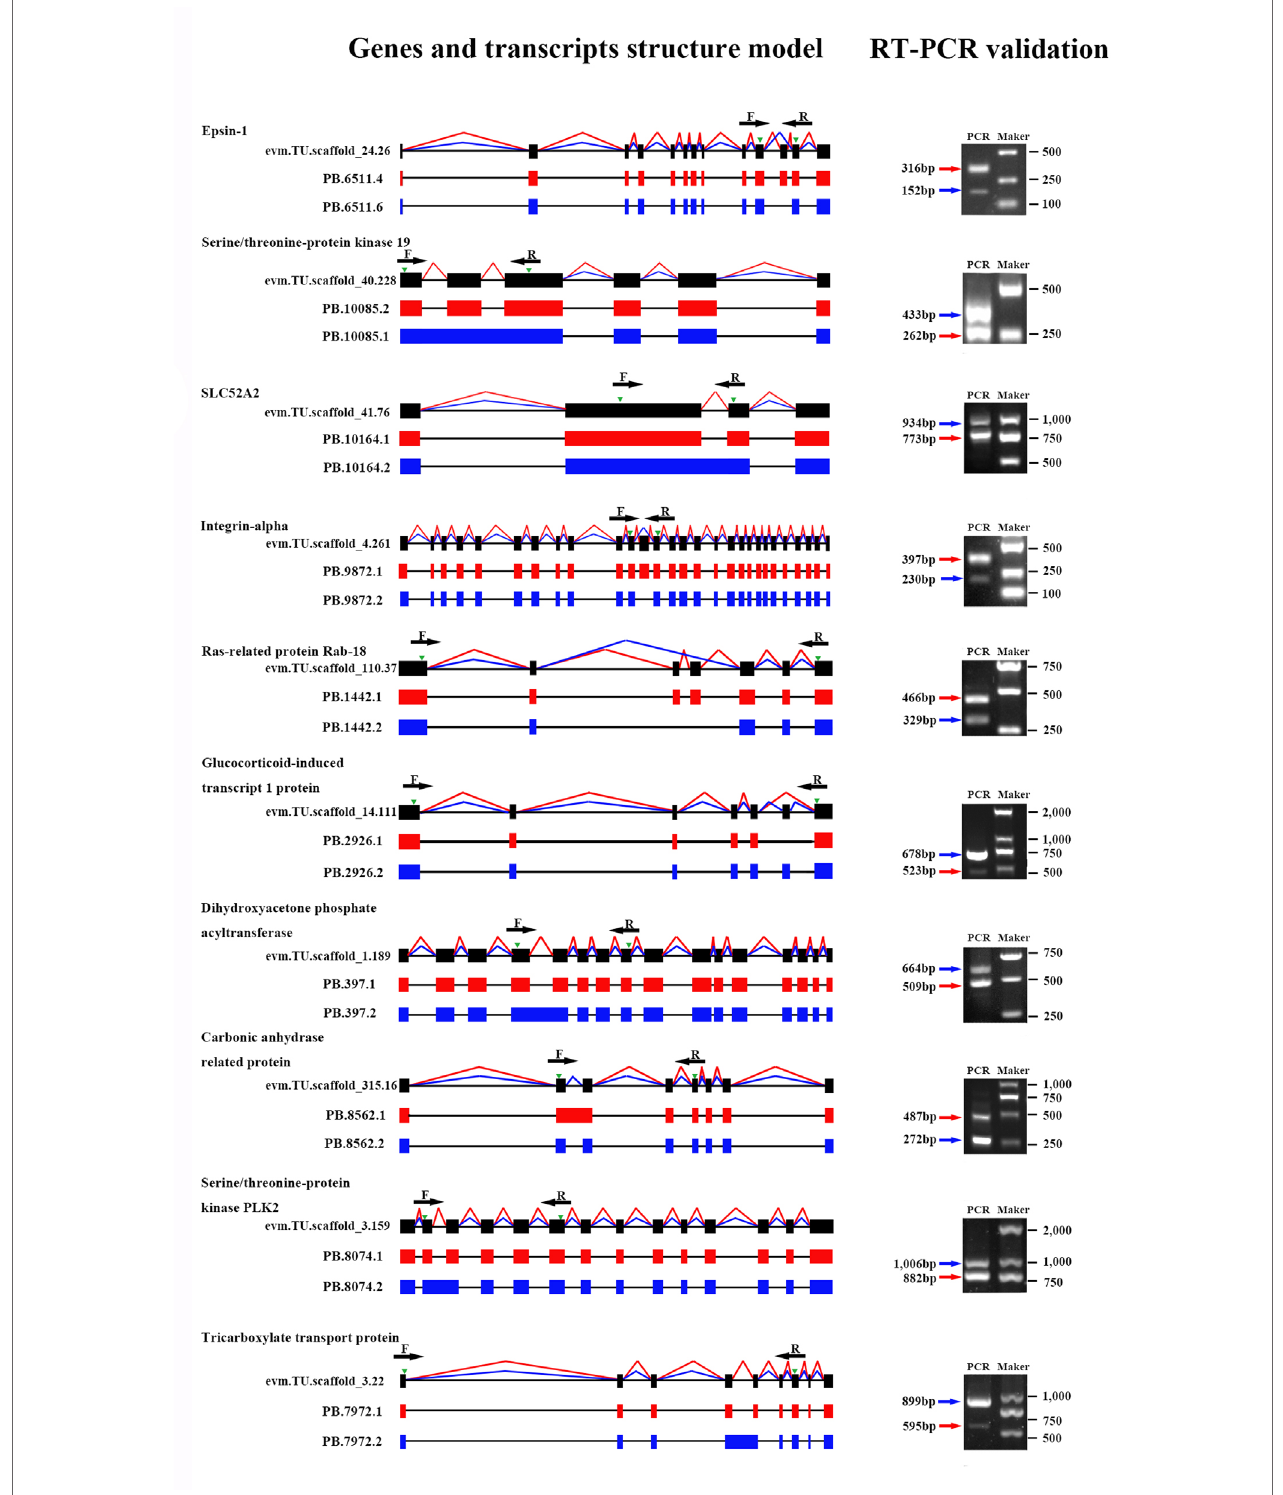
FIgURe 4 | Validation of alternative splicing (AS) events by RT-PCR. Ten AS events were randomly selected for RT-PCR validation. Gene name, gene ID, and transcript ID were shown in order to the left of the gene model. Splicing events of different transcripts were shown by red or blue lines connecting exons, and green arrowheads indicated the position of PCR primers (F, forward and R, reverse). Introns are represented by black lines. In the agarose gel images, the red or blue arrowheads indicated the PCR products generated from the corresponding transcripts.